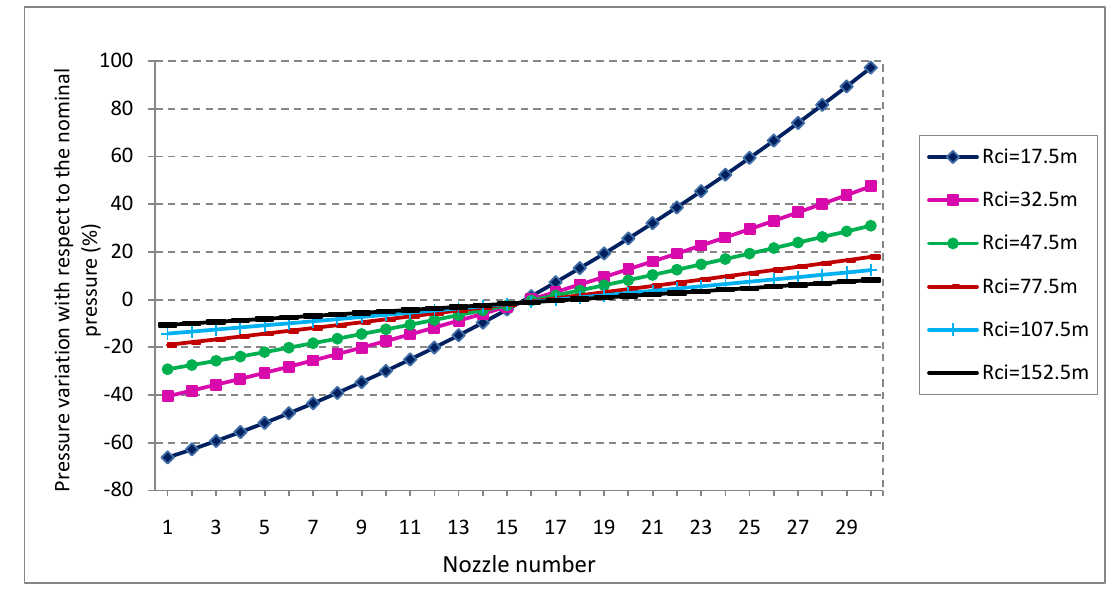
Figure 9. Percentage of pressure variation with respect to the nominal pressure considering the individual regulation of the nozzle pressure of a 14.5 m boom to obtain an uniform surface dose. Data have been obtained considering a 14.5 m boom sprayer carrying out treatment in circular trajectories in a circular plot with a 160 m-in radius at a displacement velocity of 7 km/h, and a nominal pressure of 2 bar (nozzle flow of 1.4